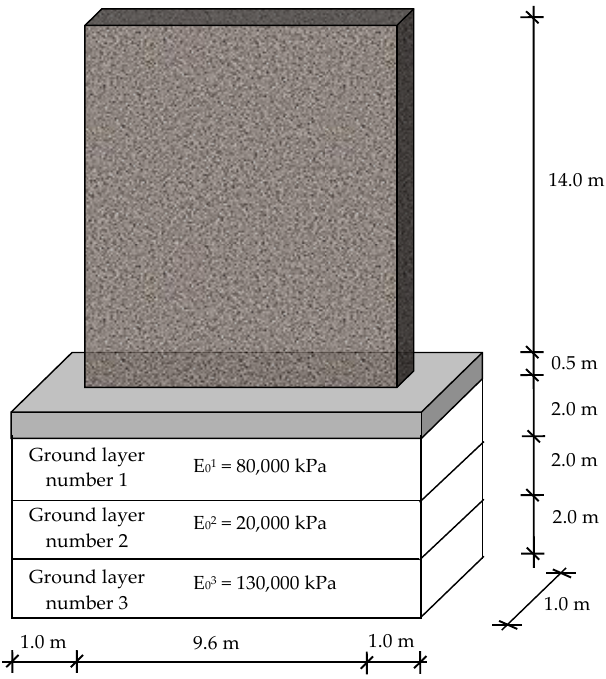
Figure 8. Parameters of multi-layered subsoil calculation model.